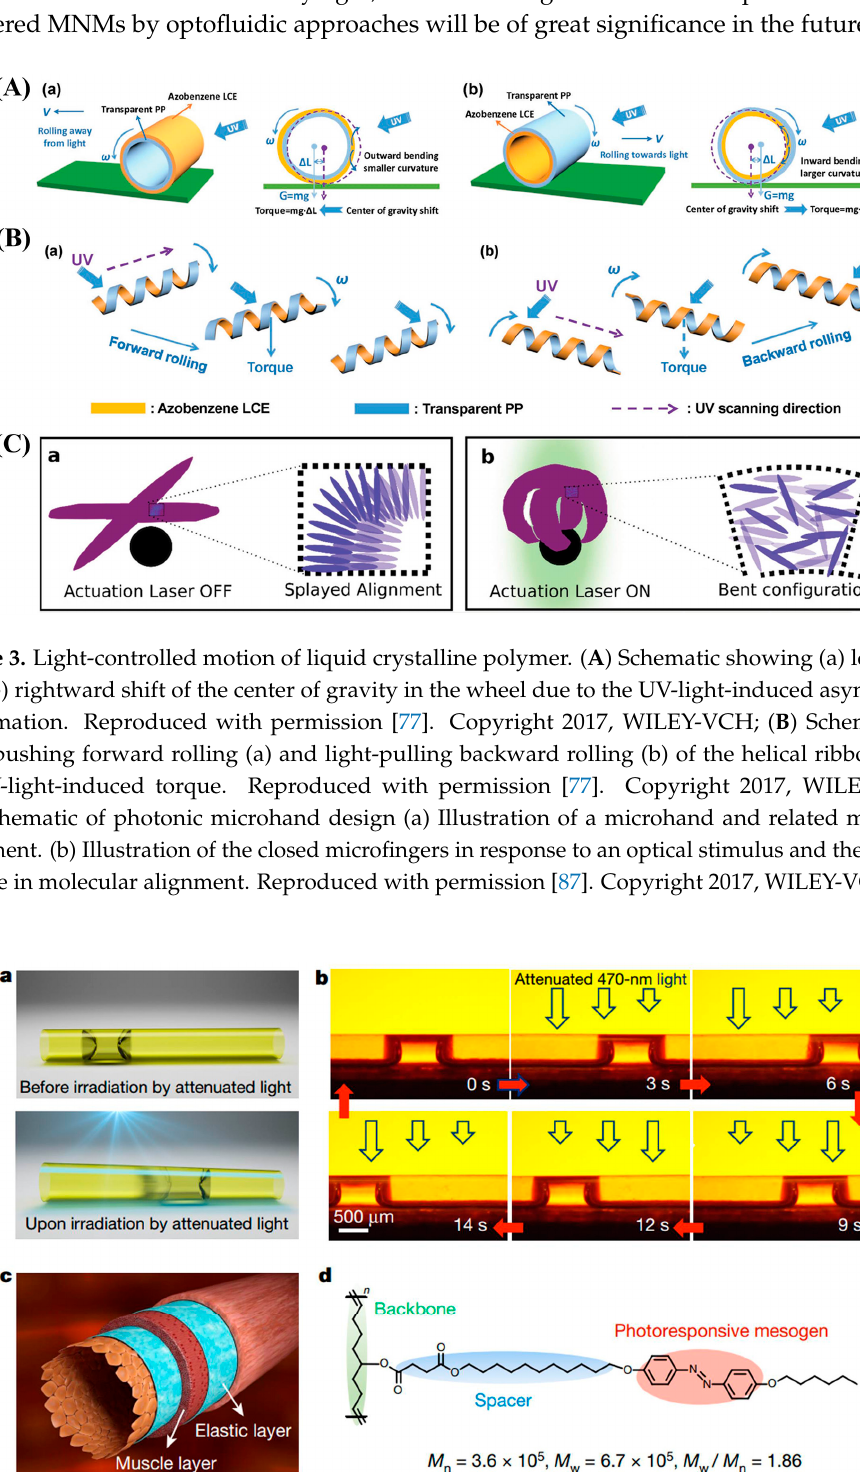
Figure 4. Design of tubular microactuators. ( a ) Schematics showing the motion of a slug of fully wetting liquid confined in a tubular microactuator (TMA) driven by photodeformation; ( b ) Lateral photographs of the light-induced motion of a silicone oil slug in a TMA fixed on a substrate; ( c ) Schematic illustration of the structure of artery walls; ( d ) Molecular structure of a novel linear liquid crystal polymer (LLCP). Reproduced with permission [78]. Copyright 2016, Nature Publishing